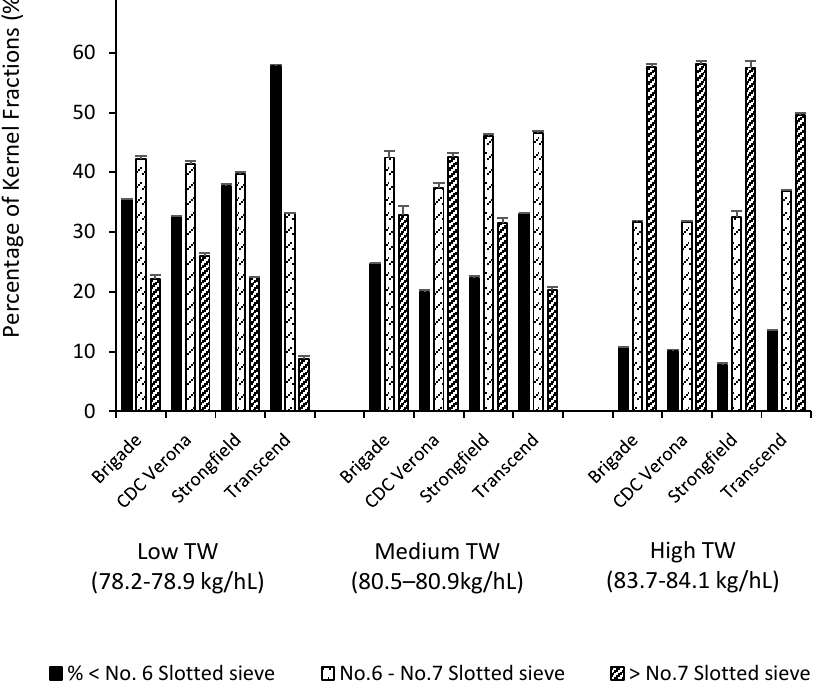
Figure 3. Impact of genotype and test weight on kernel size distribution of durum wheat.